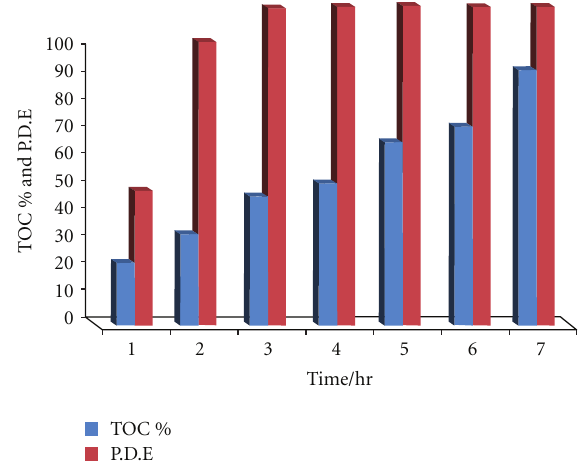
Figure 13: TOC degradation % and P.D.E for cobalamin by TiO 2 (Degussa